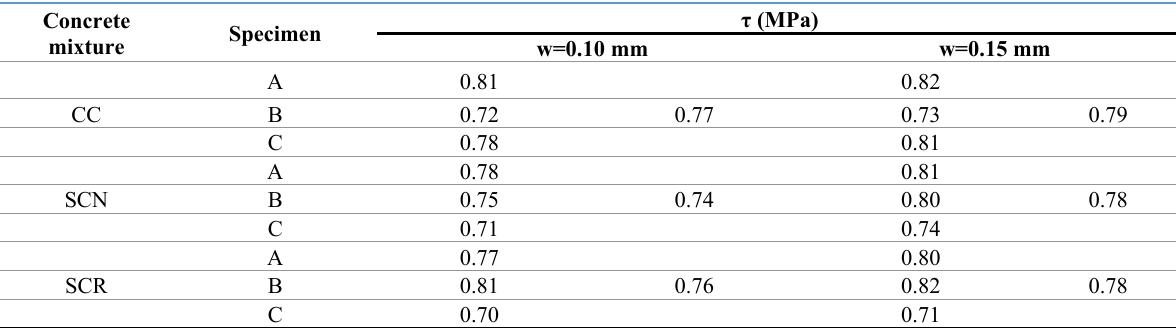
Table 5. Normalized shear stresses at crack width of 0.10 and 0.15